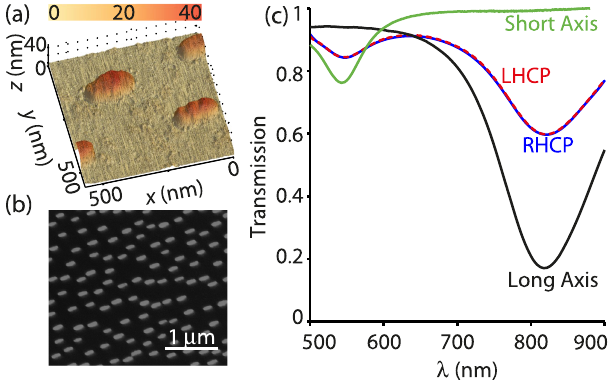
FIG. 2. Sample properties. (a) Atomic force micrograph and (b) scanning electron micrograph of the elongated gold nano- particles. (c) Optical properties of the array measured at normal incidence ( θ i ¼ 0 °) displaying the in-plane short- and long-axis resonances and the responses for circularly polarized